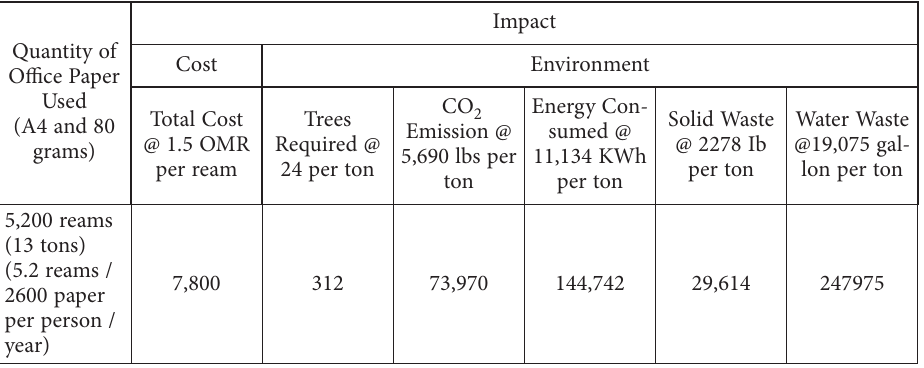
Table 7. Impact of 5,200 reams (13 tons) of Paper used by three Selected Educational Institutions in Dhofar Region of Oman in one year (I OMR = 2.60 US$)